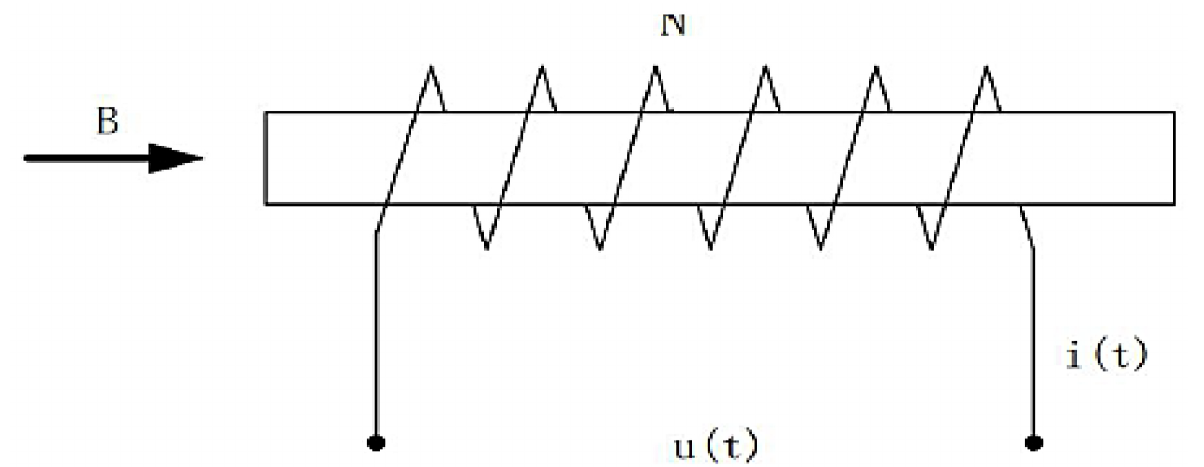
Figure 12. The structure of single-core winding fluxgate